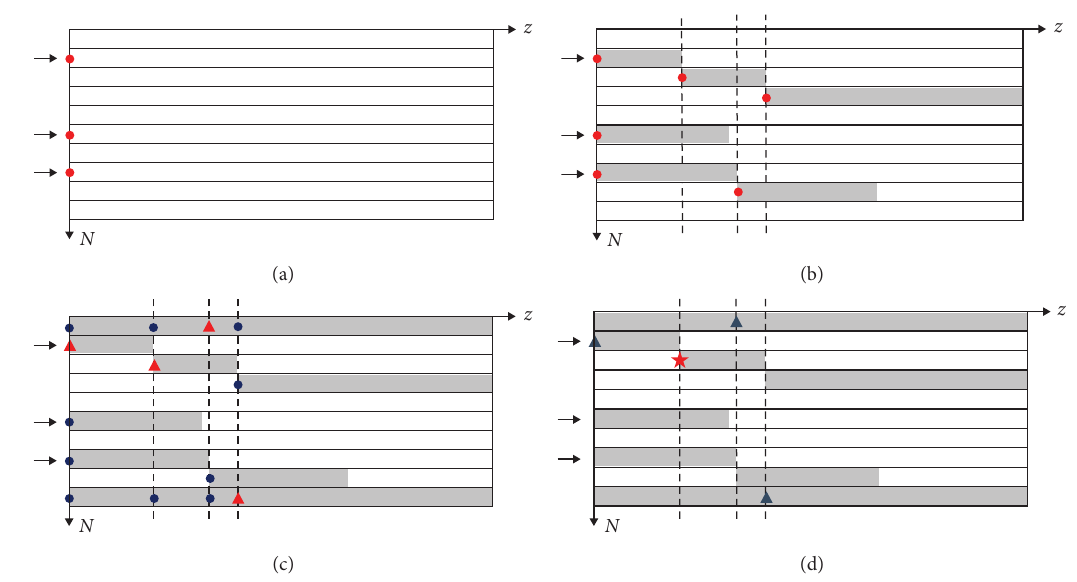
Figure 3: Steps of the solution algorithm. (a) Step 1. (b) Step 2. (c) Step 3. (d) Step